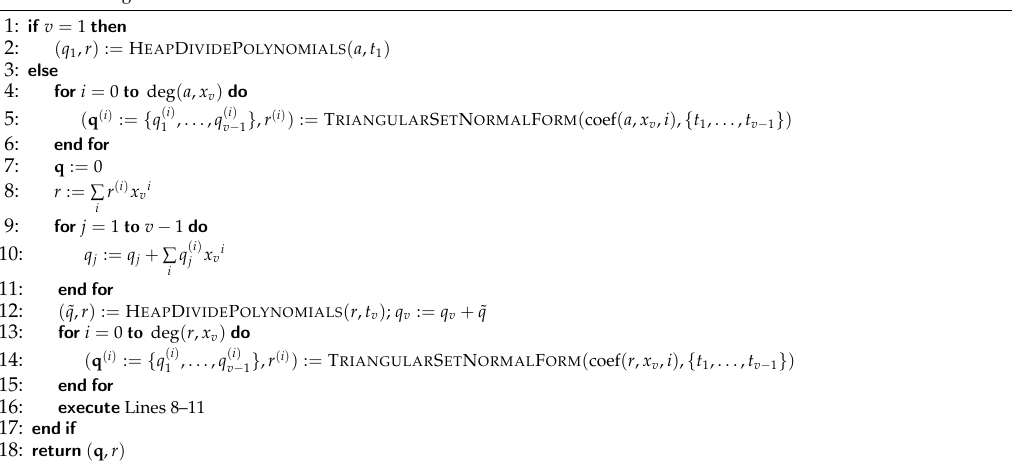
Algorithm 7 T RIANGULAR S ET N ORMAL F ORM ( a , T ) Given a ∈ K [ x 1 ,..., x v ] , T = { t 1 ,..., t v } ⊂ K [ x 1 ,..., x v ] , with x 1 = mvar ( t 1 ) < ··· < x v = mvar ( t v ) and init ( t 1 ) ,...,init ( t v ) ∈ K , returns q = {